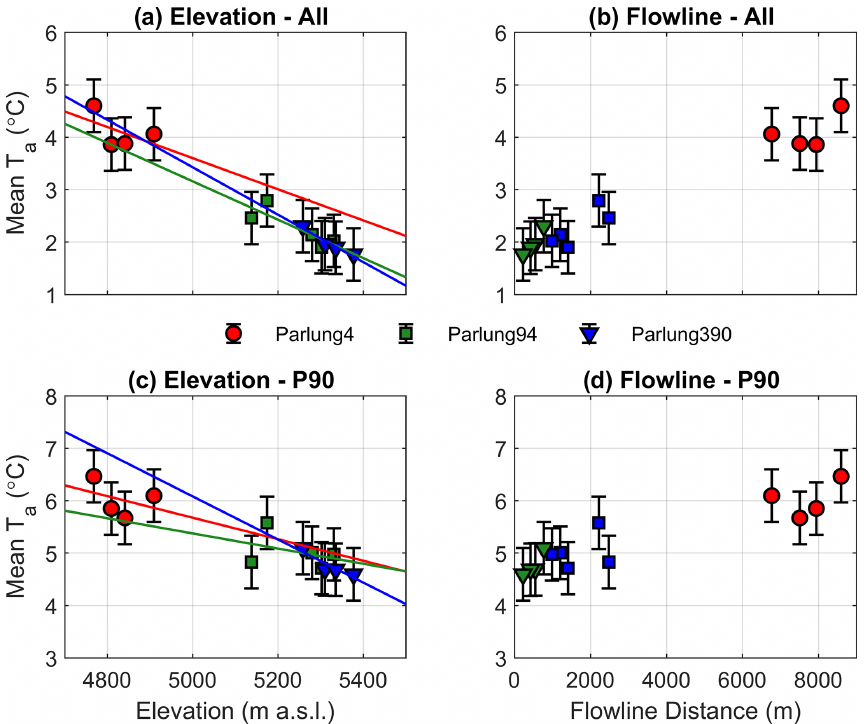
Figure 3. The mean T a against elevation and uncertainty (error bar) for (a) all hours ( n = 3312) and (c) P90h ( n = 312). Panels (b) and (d) are the equivalent plots against flowline distance. Coloured lines show the linear fit against elevation (lapse rate) to each glacier.